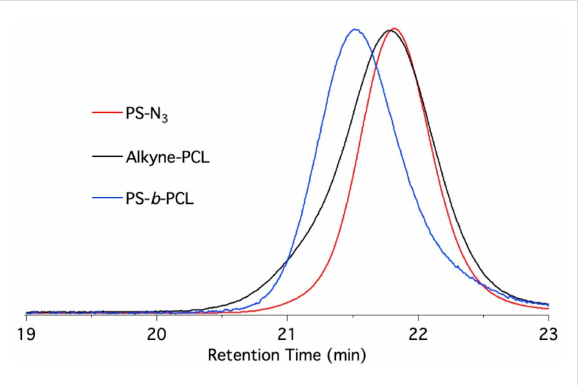
Figure 6: Block copolymerization of the precursors PS-N3 and Alkyne-PCL results in the block copolymer PS- b -PCL as shown by the respective GPC